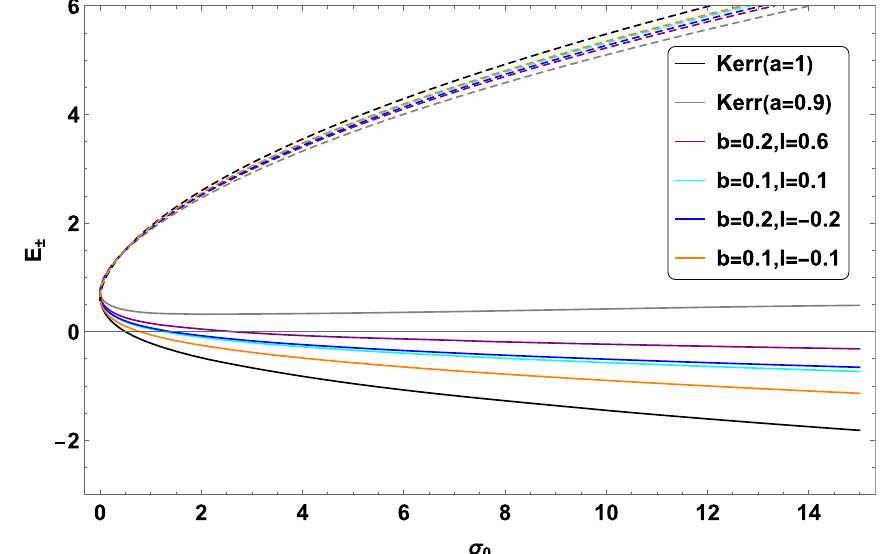
r = r isco for each different curve ( model ). The plotted models all have efficiency η > 1 and maximum extractable energy with respect to Kerr case, i.e. η rot ≥ 29%. Finally, keep in mind that optimal (but too unre- alistic) conditions would be ξ = 0 and r = r in , where r in the outer event horizon. All quantities on the axes are adimensional